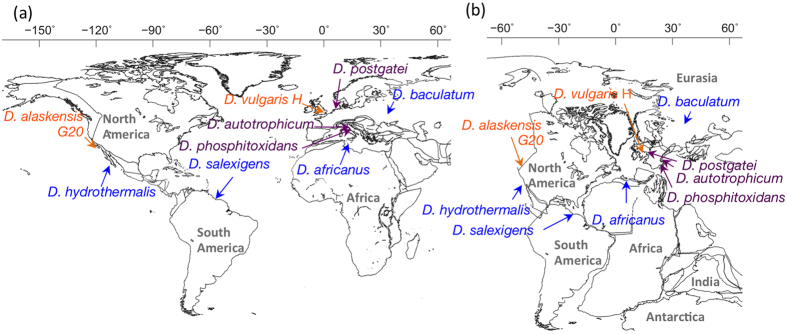
Geographic positions where the SRB strains were isolated are located on the current world map(a) and on the PANGEA continent 200 Mya (b). Maps were created with GPlates visualisation software as described previously36.